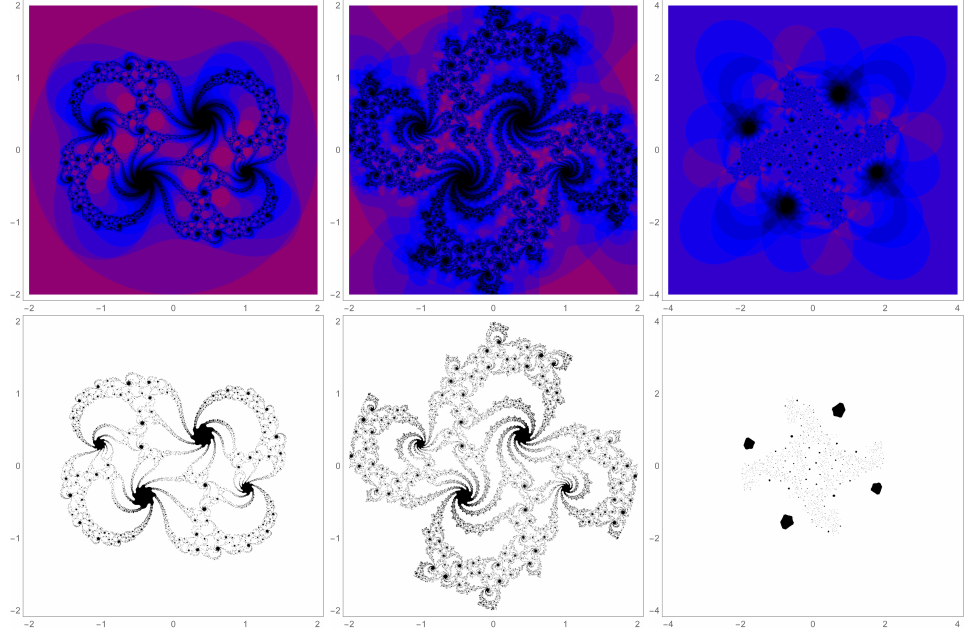
Figure 7. A few intricate and impressive looking j -averaged filled-in Julia sets coming from the mouth regions of one of the three larger orbiting domains. For all plots j = 100, sampled as a 1M pt square lattice. Top left λ = − 0.475 + 0.13 i , top middle, λ = − 0.46 + 0.135 i , top right λ = − 0.471 + 0.006 i . The bottom row simply shows the filled-in Julia set.